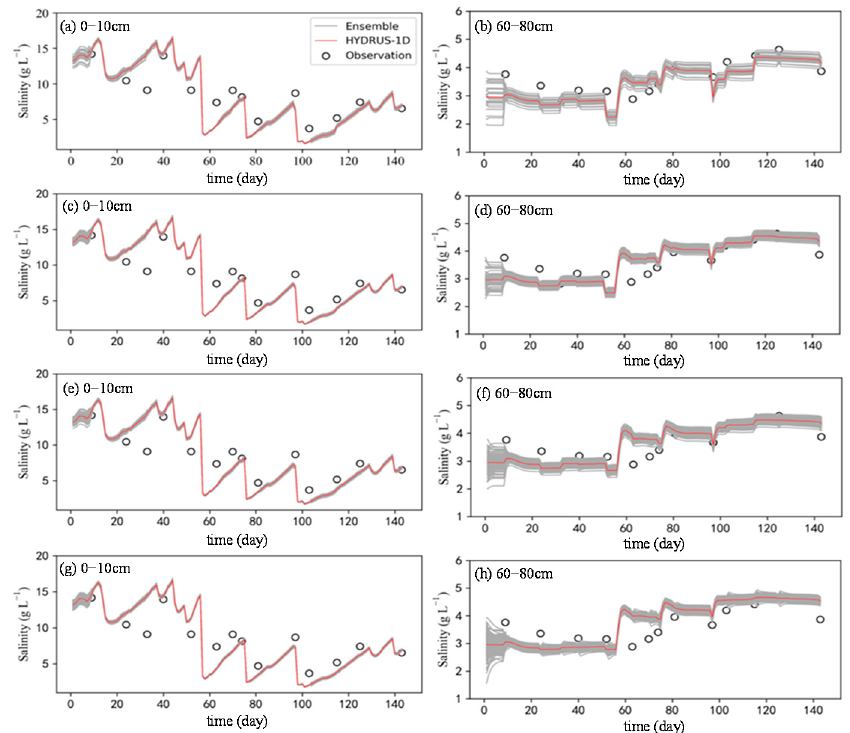
Figure 13. Simulated salinity at different depths with different ensemble sizes, ( a ) 0–10 cm, with an ensemble size of 30; ( b ) 60–80 cm, with an ensemble size of 30; ( c ) 0–10 cm, with an ensemble size of 50; ( d ) 60–80 cm, with an ensemble size of 50; ( e ) 0–10 cm, with an ensemble size of 100; ( f ) 60–80 cm, with an ensemble size of 100; ( g ) 0–10 cm, with an ensemble size of 200; ( h ) 60–80 cm, with an ensemble size of 200.